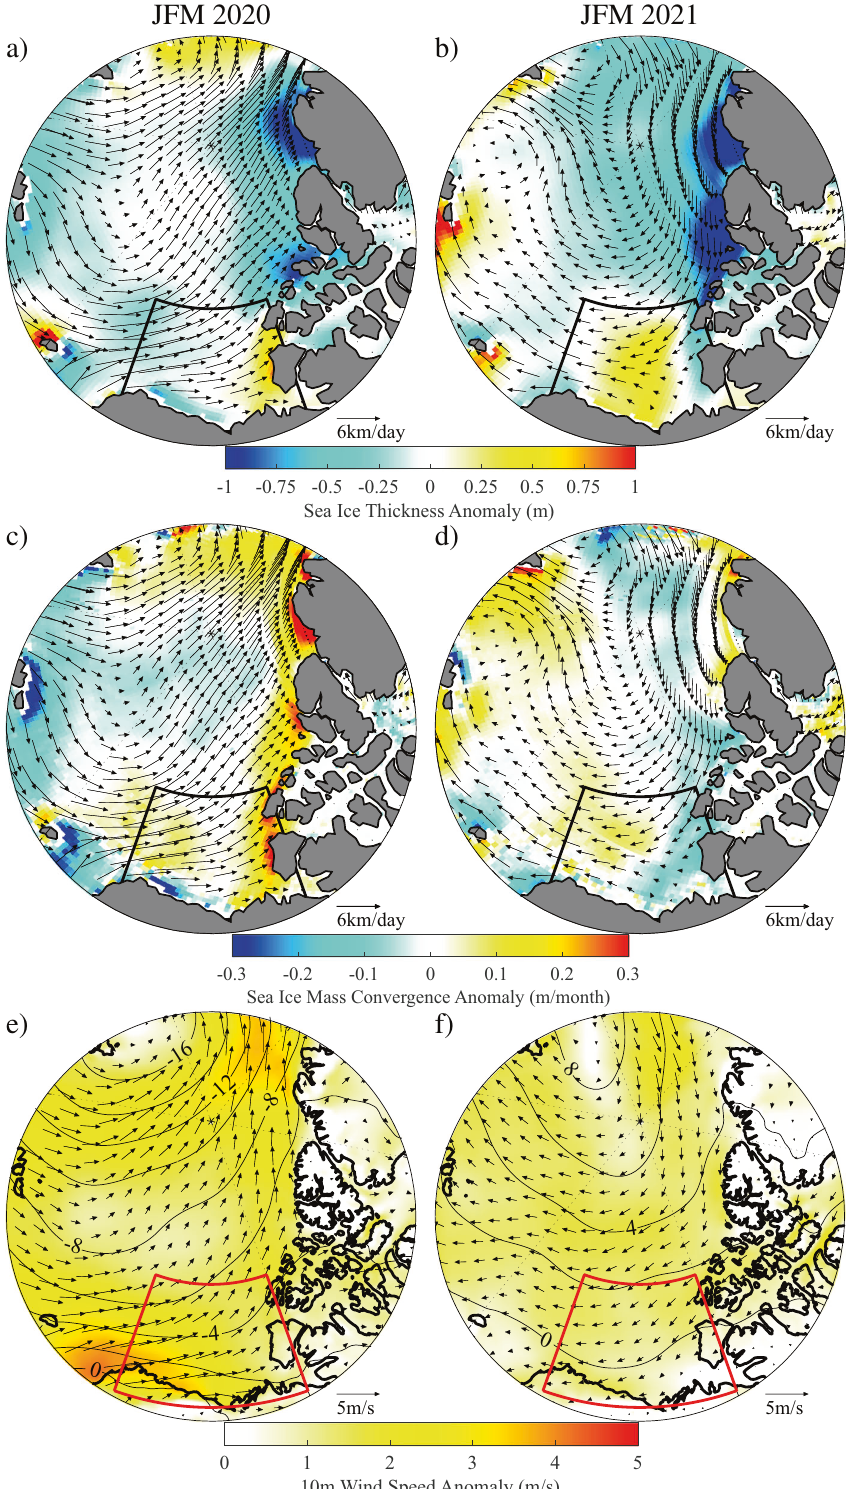
Fig. 6 Anomalous nature of the winter (JFM) sea ice and atmospheric circulation during 2020 and 2021. Sea ice thickness (shading - m) and sea ice motion (vectors- km/day) anomalies with respect to climatology (2007 – 2019) for: a 2020 and b 2021. Sea ice mass convergence (shading - m/month) and sea ice motion (vectors- km/day) anomalies with respect to climatology (2007 – 2019) for: c 2020 and d 2021. Sea-level pressure (contours - mb), 10 m wind (vectors- m/s) and 10 m wind speed (shading-m/s) anomalies with respect to climatology (1979 – 2021) for: e 2020 and f 2021. The polygon indicates the region along the Beaufort Coast over which statistics were computed. Sea ice fi elds are from PIOMAS. Atmospheric fi elds are from ERA5.